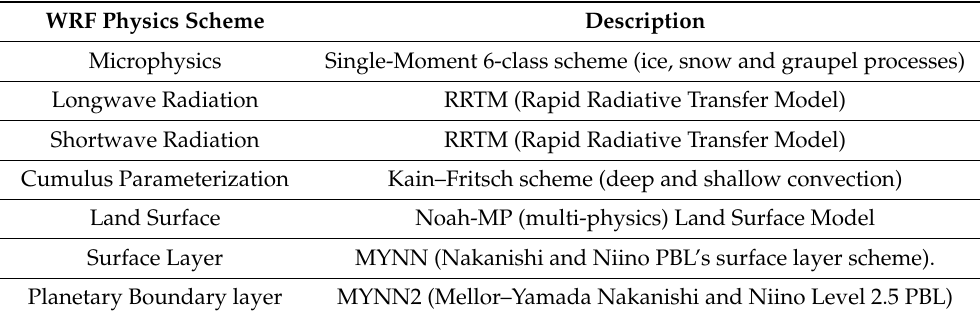
Table 1. Advance Research Weather Research and Forecasting (WRF-ARW), the Physics